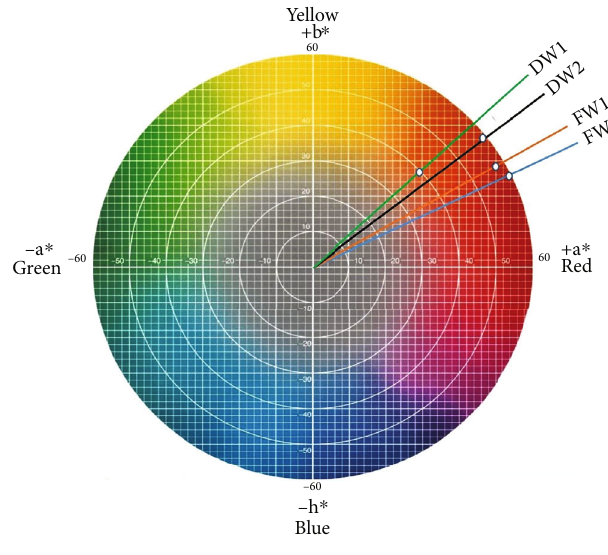
Figure 2: Wine colour spectrum.